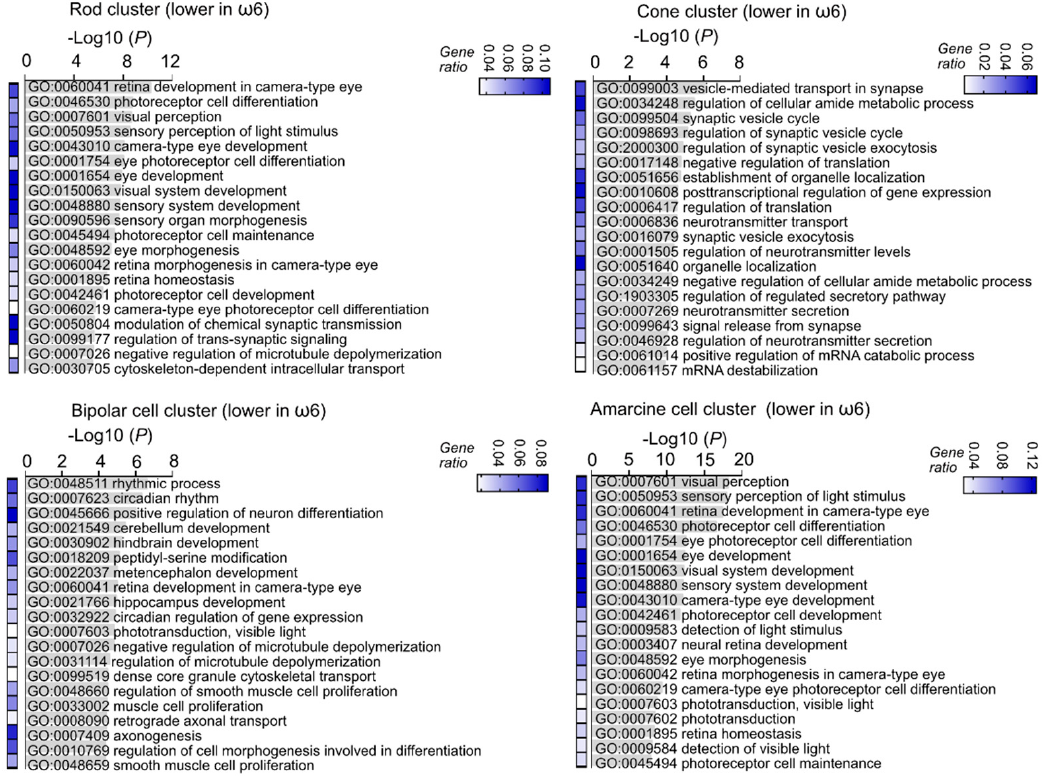
Figure 4. ω -6 vs. ω -3 accelerated neural retinal maturation identified with single-cell analysis. The lower expression of genes in the rod, cone, bipolar, and amacrine cell clusters of ω -6 versus ω -3 LCPUFA-fed Phase I ROP mice were associated with visual signal transduction (synapse-related, circadian rhythm) and eye development related gene ontology terms. Adjusted p -values for enriched gene ontology (GO) terms are shown in bar graphs ( p < 0.05). Gene ratio for each pathway is shown in heatmap.